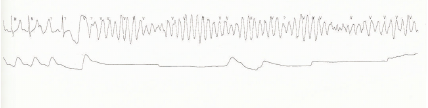
to light. He was tachycardic with a regular rhythm.